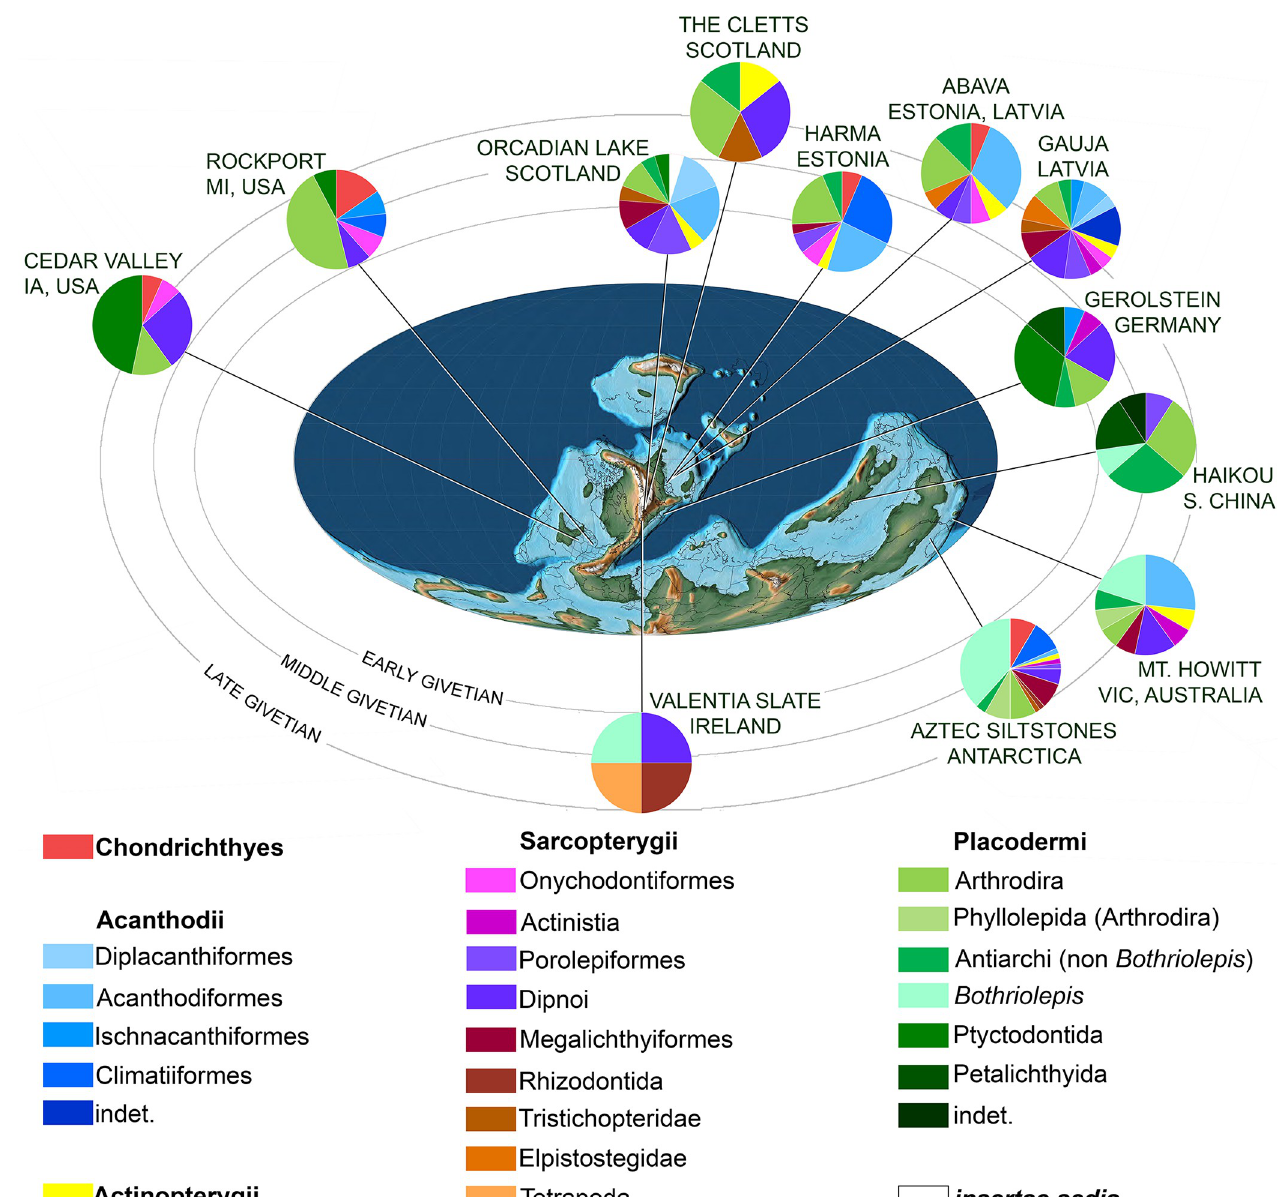
Fig 16. Distribution and composition of Givetian vertebrate faunas based on macroremains. Pies correspond to best known localities and associated updated taxa formerly listed in Sallan and Coates [96], with the addition of Valentia Slate formation; they are plotted on a palaeomap of the Givetian (modified after [38]; oceans in dark grey, shallow and epicontinental seas in light grey, emerged continents in white). Early Givetian localities have their pies closer to the edge of the map; late Givetian are furthest. NB. 13 unnamed and indeterminate species of Bothriolepis in Antarctica mentioned by Young [25] are taken in consideration in this